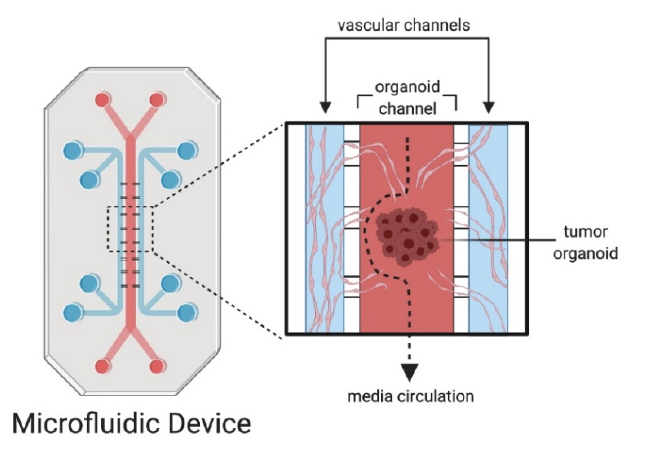
Figure 2. Microfluidic devices and organoids on chips. Microfluidic chips can be designed to culture organoids in a chamber connected to an inlet that can circulate culture media. In a vascular organoid- on-chip model, tumoroids are cultured in a central chamber. Adjacent chambers are connected to the central chamber and endothelial cells with fibroblasts are cultured in hydrogel. The tumoroid cultures are perfused with vasculature and can model